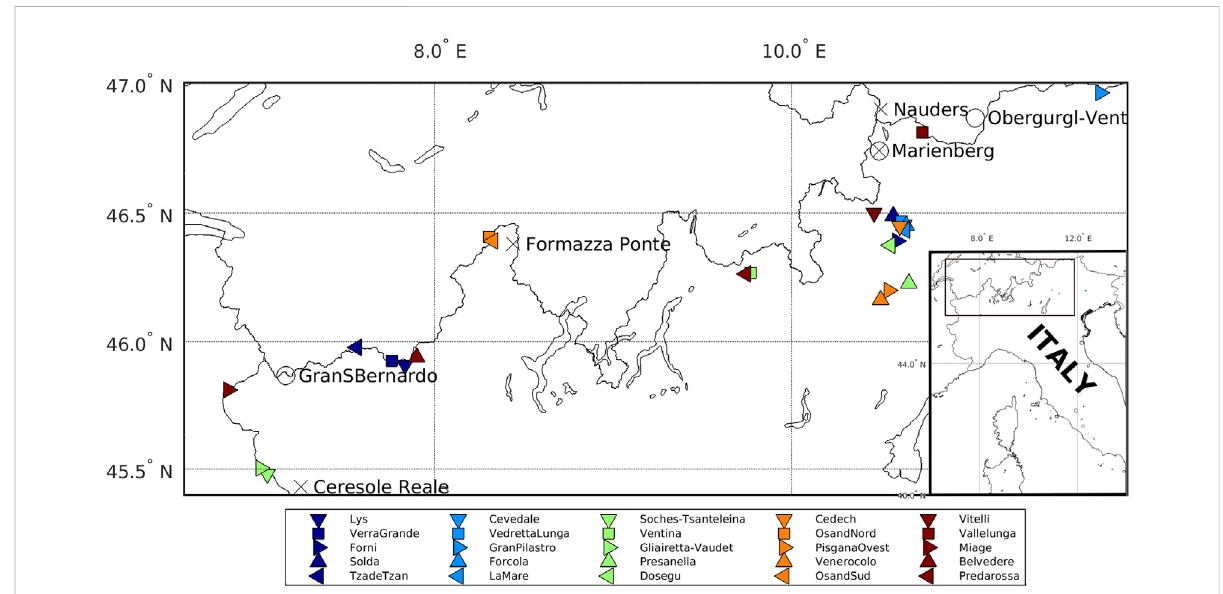
FIGURE 1 The position of the glaciers and in situ climatological stations considered in this work. Circles indicate the stations providing air temperature, crosses the